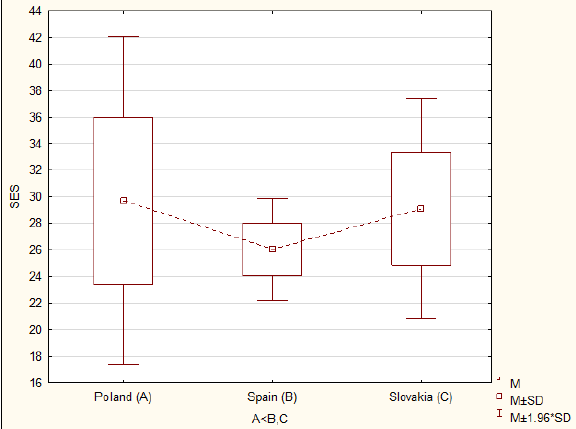
Figure 1. Comparison of average results of life satisfaction according to SES among Polish, Spanish and Slovak students.